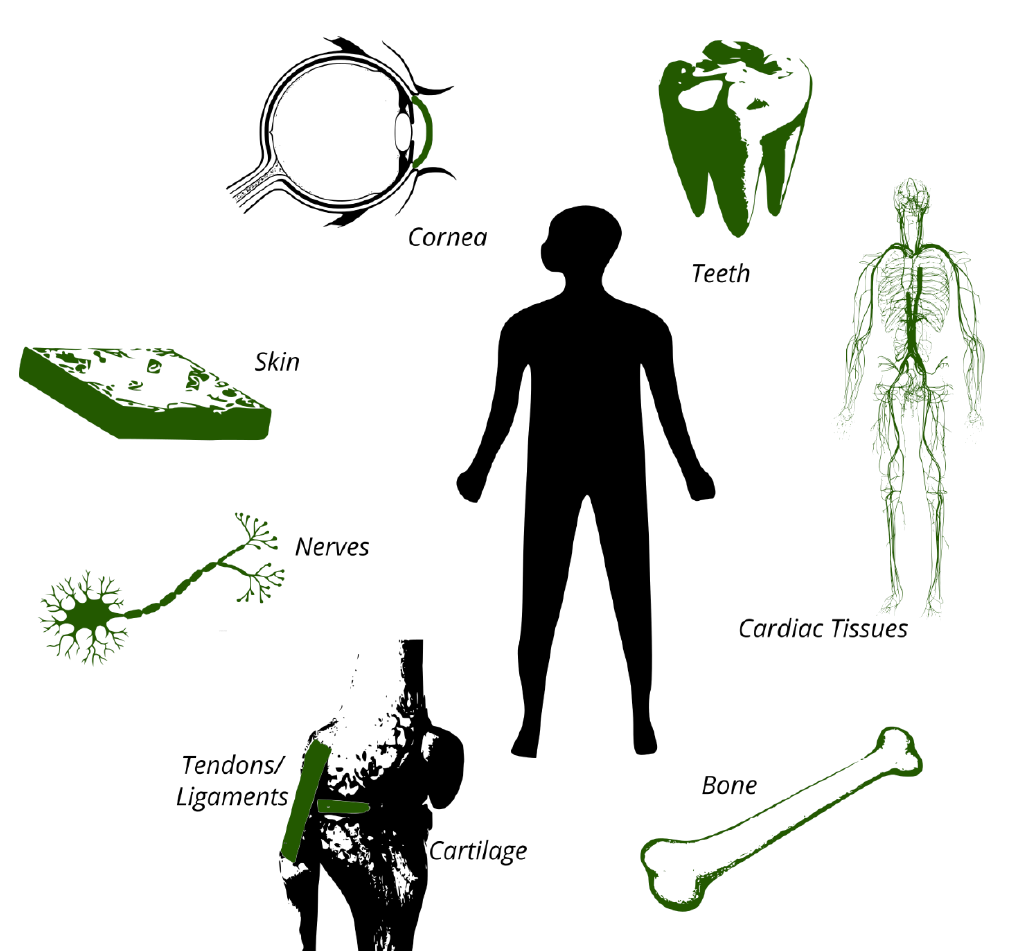
Figure 2. The most important tissues for TERM include cartilage, skin, bone, cornea, nerves, tendons, ligaments, cardiac tissues (arteries, heart valves, and myocardium), and teeth.